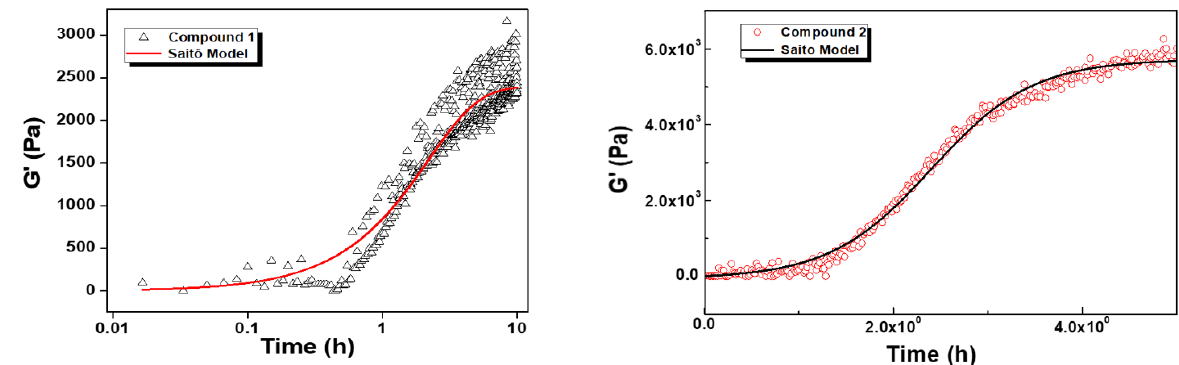
Figure 6. Time dependence of the storage modulus G ′ (symbols) recorded during the gelling of compounds 1 and 2 , fitted with Equation (1)–line.